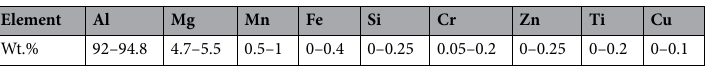
Table 1. Elemental composition of AA5456 alloy.